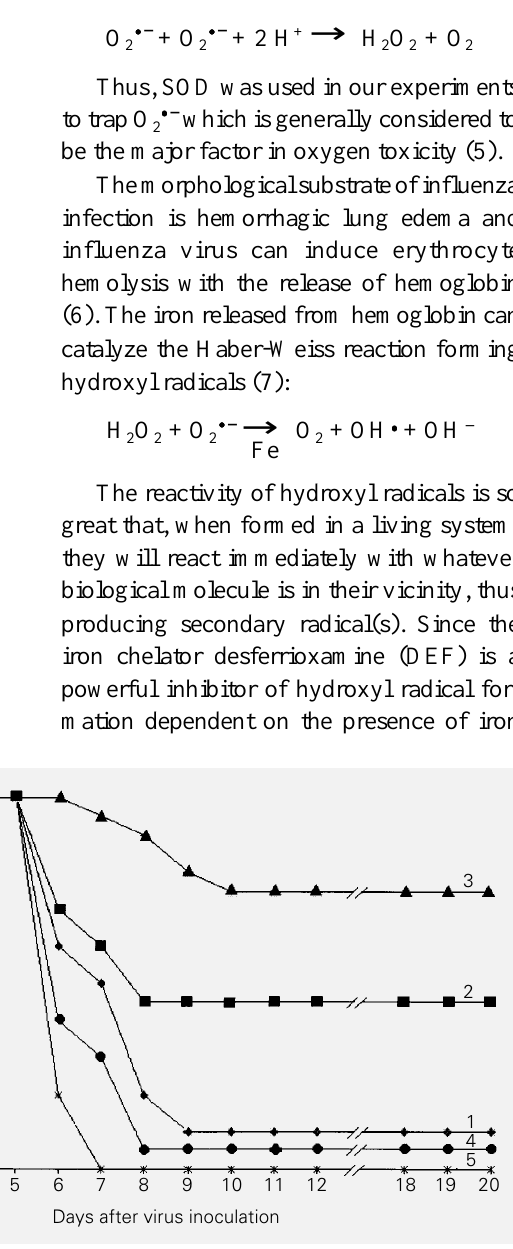
Figure 1 - Effect of antioxidant treatment on the mortality of mice infected with influenza virus. Male CBA mice were infected intranasally with 2-5 LD 50 lung influenza virus A/Aichi/ 2/68 (H2N2). Data are reported as the mean of 3 independent experiments for which 20 mice were used for each group. Curve 1 : Control group. Curve 2 : SOD, 1000 U/day iv on days 5, 6, 7 and 8 after inoculation. Curve 3 : SOD, 1000 U/day iv on days 4, 5, 6, 7 and 8 after inoculation. Curve 4 : Desferrioxamine, 25 mg/kg per day sc , divided into two applications. Curve 5 : Desferrioxamine, 100 mg/kg per day sc , divided into two